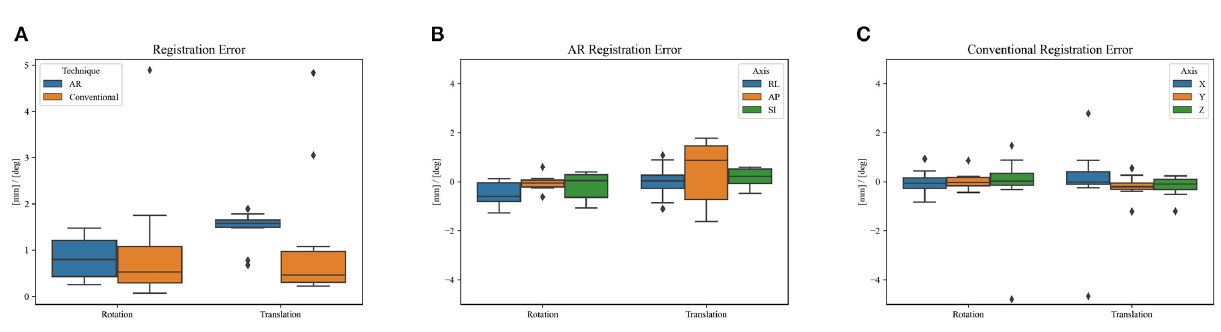
FIGURE8 Phantom registration error of AR and conventional neuronavigation techniques shown as an error in rotation and translation. (A) Total registration error magnitudes; (B) AR registration error vectors (RL, right-left; AP, anterior-posterior; SI, superior-inferior; orientations defined in CT space). (C) Conventional neuronavigation registration error vectors. The black diamonds represent outlier data.